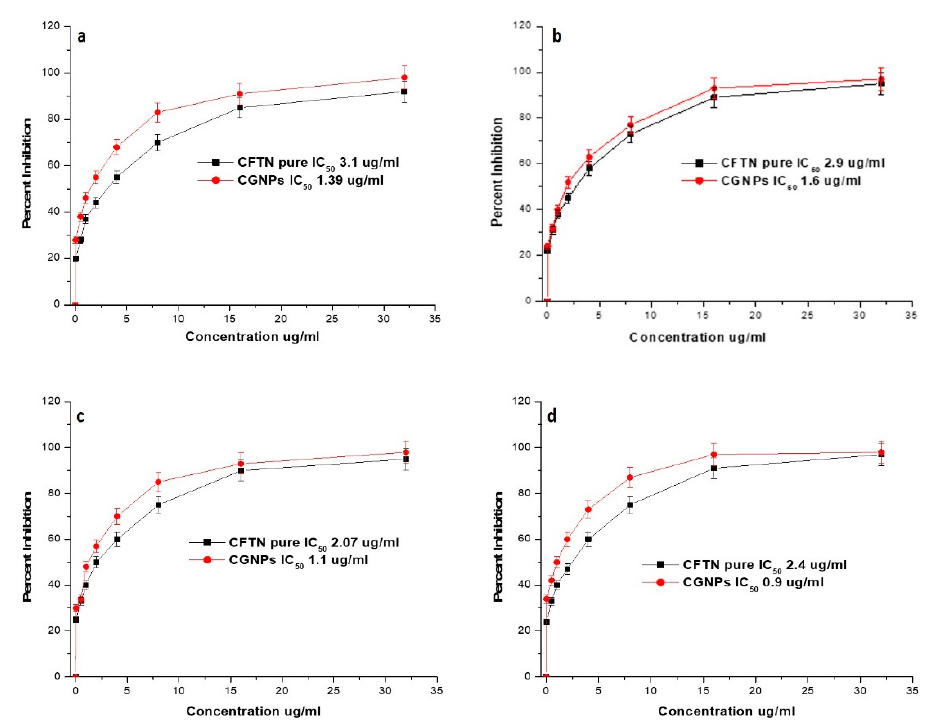
Figure 8. Determination of Minimum Inhibitory Concentration (MIC) of CGNPs and ceftriaxone (CFTN) against ( a ) Escherichia coli , ( b ) Staphylococcus aureus , ( c ) Salmonella abony , and ( d ) Klebsiella pneumoniae.